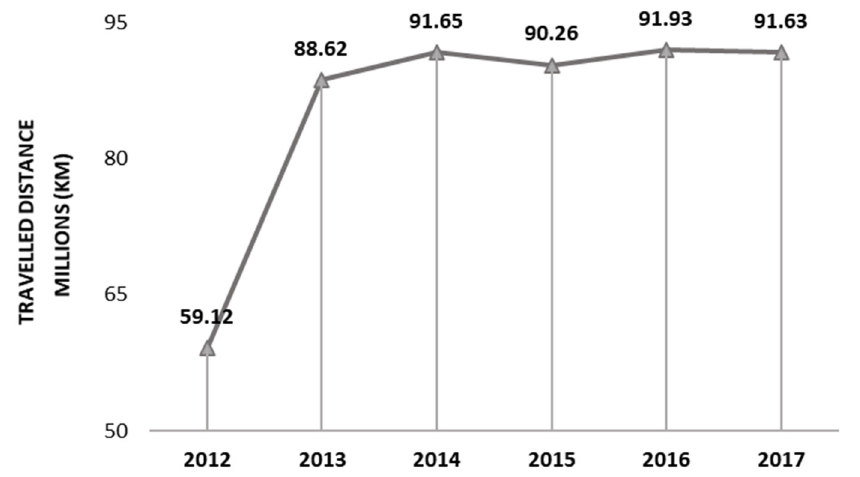
Figure 4. Estimate of distances traveled by MSW truck's vehicles.